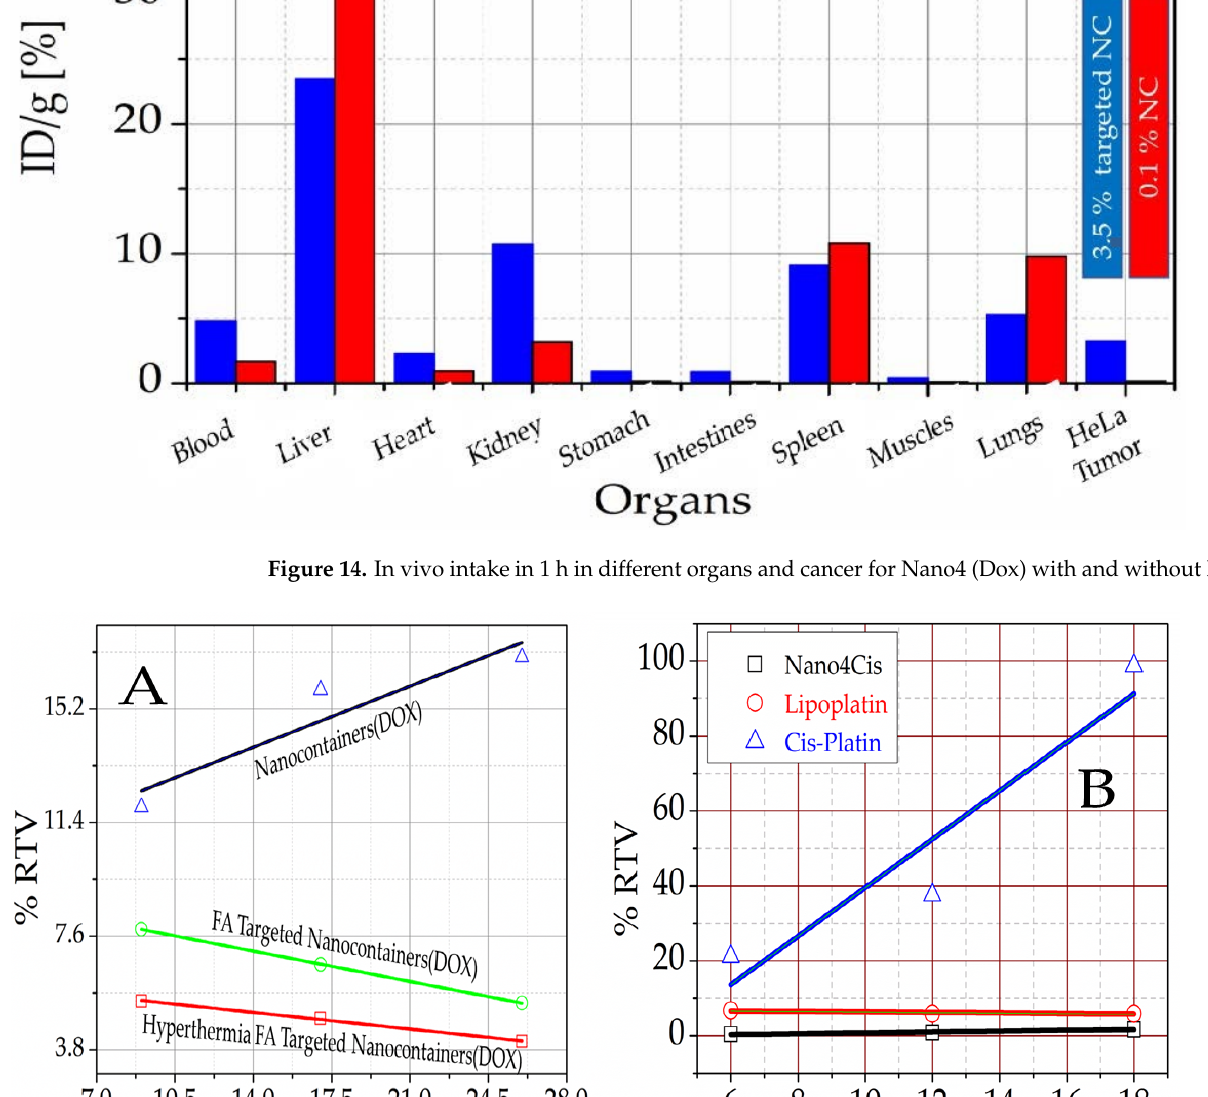
Figure 14. In vivo intake in 1 h in different organs and cancer for Nano4 (Dox) with and without F. A.